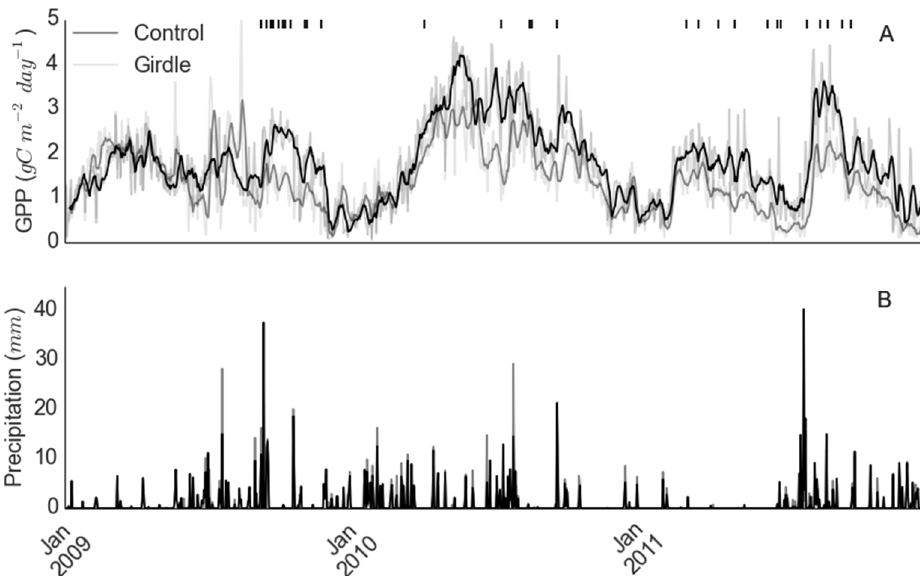
Figure 1. Time series of tower-measured gross primary production ( A ) and precipitation ( B ) at both the control (grey) and girdled (black) sites. RapidEye acquisition dates are indicated by the rug plot above the top plot.